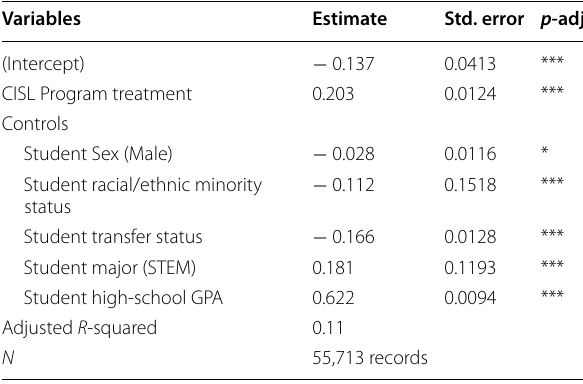
Table 4 Regression results of CISL Program treatment